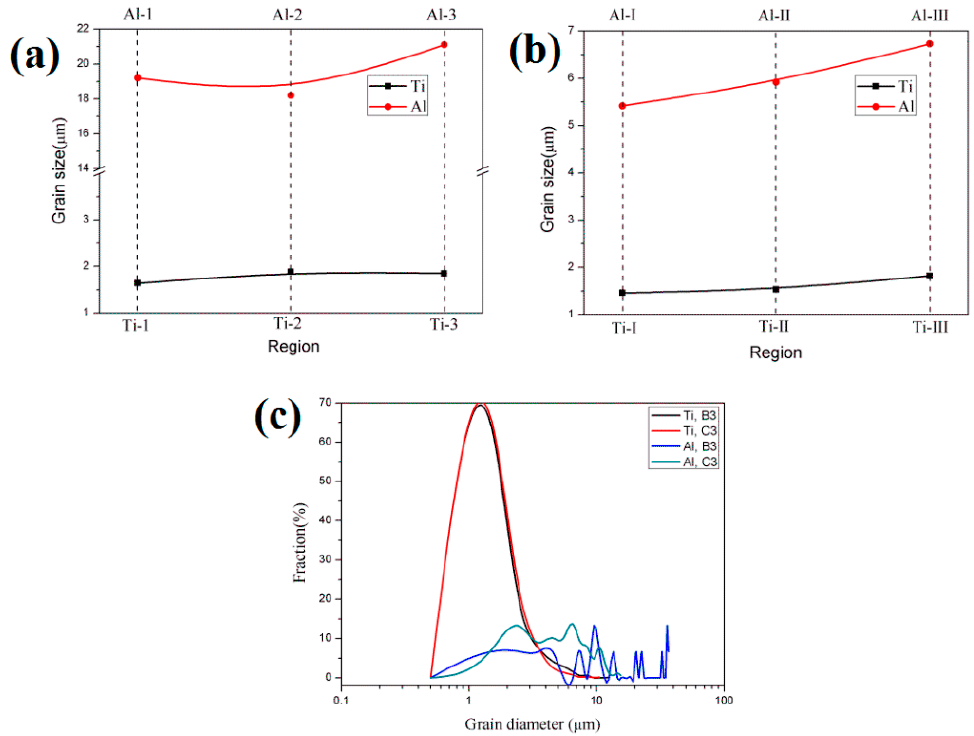
Figure 16. Grain size and distribution of each region in Figure 15. ( a ) Specimen B3; ( b ) specimen C3; ( c ) grain size distribution.